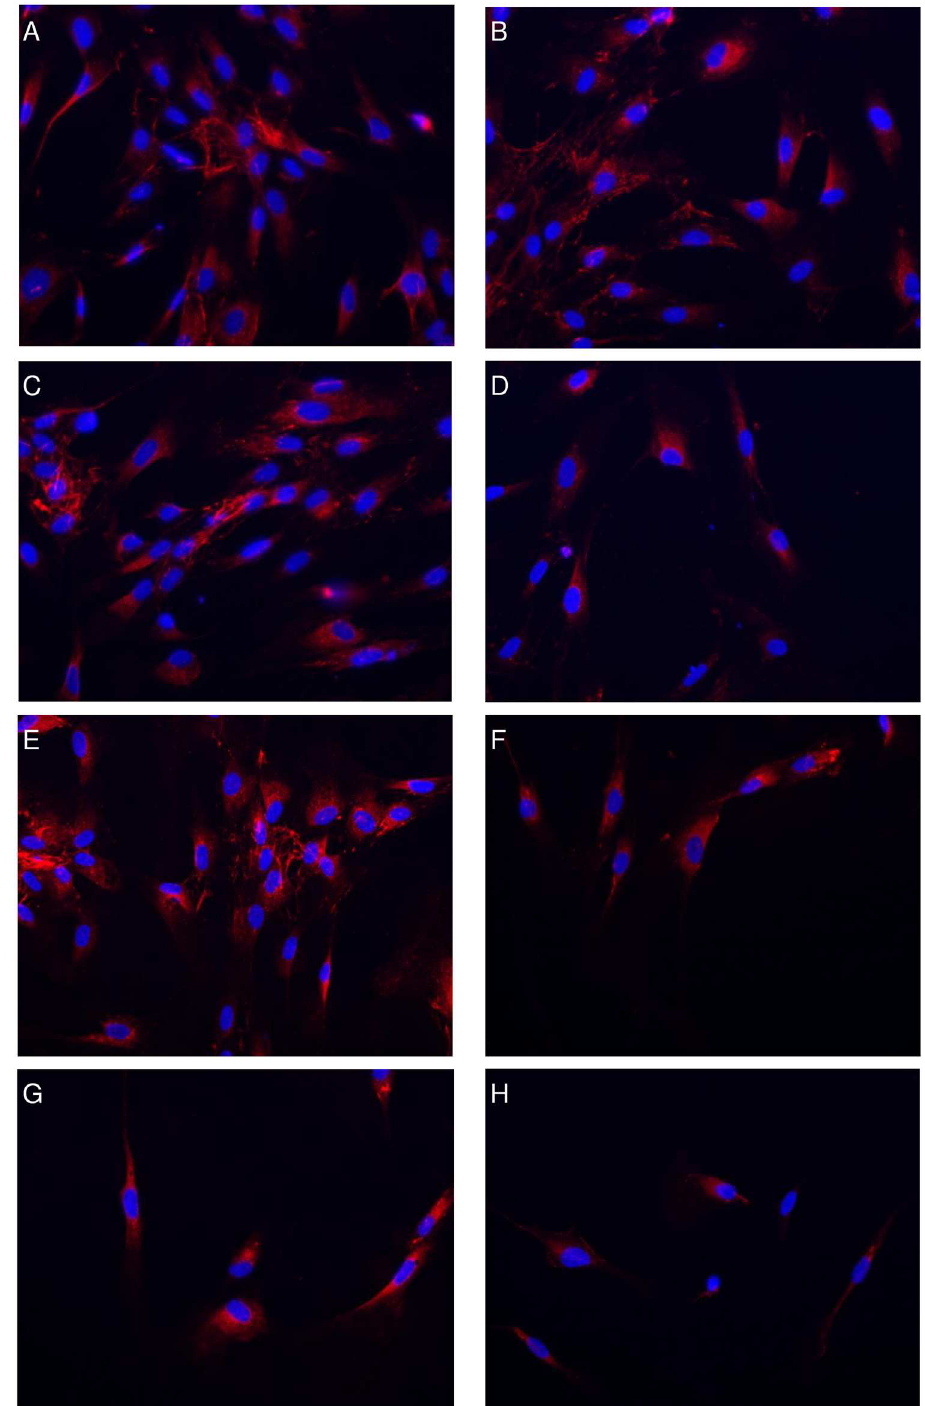
Fig 6. High concentrated Biodentine ® suspensions reduced collagen type I synthesis. The collagen type I synthesis of pulp fibroblaststreated with normal culture medium (A,B), Biodentine ® suspensionsof low (C,D), moderate (E,F) or high (G,H) Biodentine ® concentrations of day 1 (A,C,E,G) or day 2 (B,D,F,H) were immunhistochemicallymonitored.